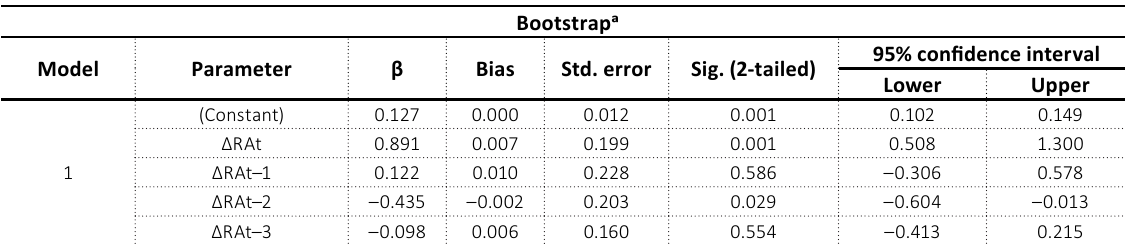
Table 6 . CEO and Director cash pay to ROA